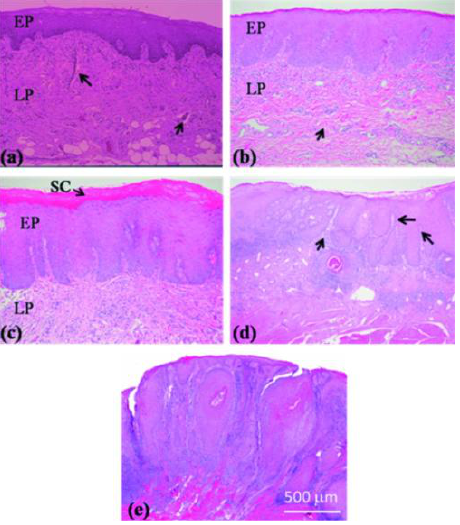
Figure 13. Histological images of the ( a ) normal, ( b ) MiD, ( c ) MoD, ( d ) ES-SCC, and ( e ) WD-SCC samples (reprinted from reference [95]).